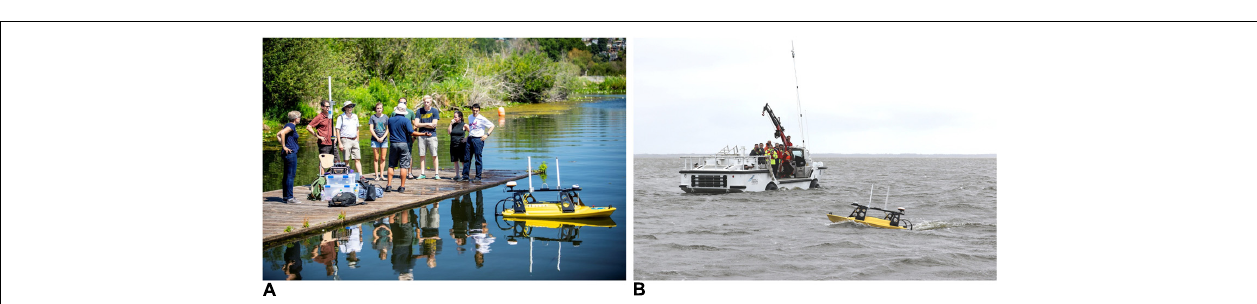
FIGURE 2 | Hydrographic survey boat in use: (A) during user training, and (B) at the DUNEX